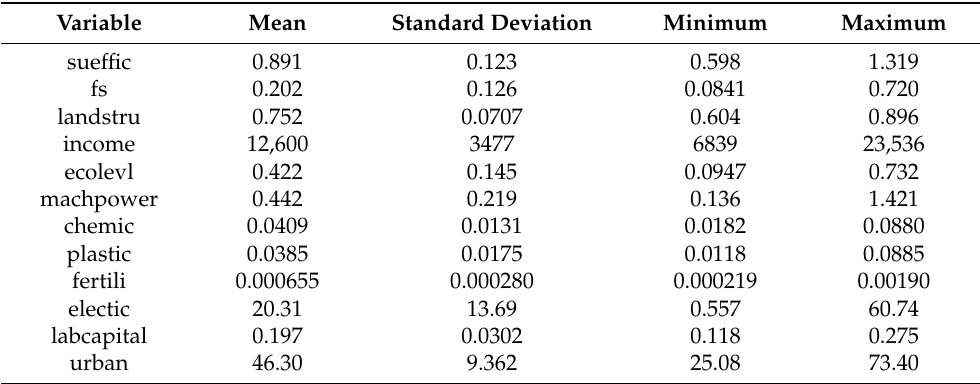
Table 7. Descriptive statistics of